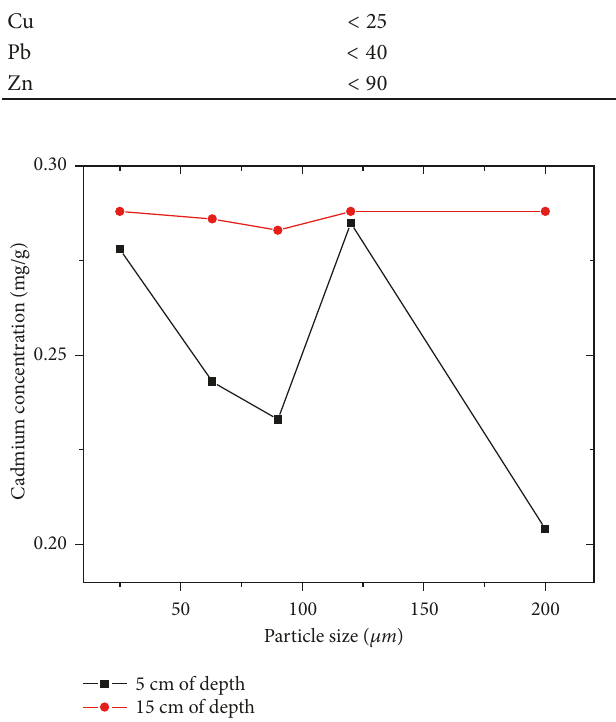
Figure 8: Evolution of cadmium concentration as a function of particle size and depth.